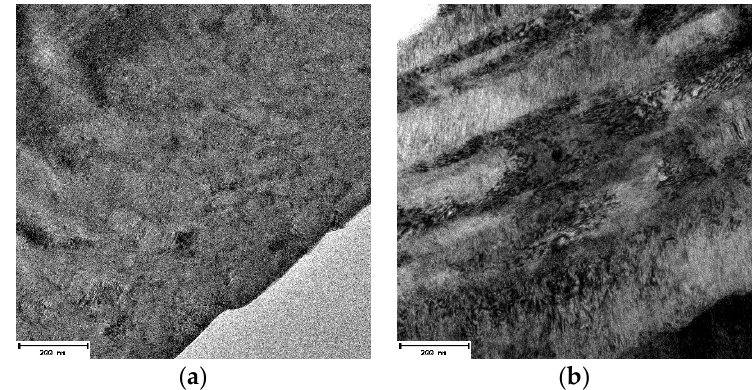
Figure 6. ( a ) TEM images with microstructural details in the transverse direction of the 331 kPa oxygen–69 kPa acetylene coating. The cutting bands are shown. ( b ) TEM image with details of the band microstructure, a density dislocation in the structure, and fine-grained areas.